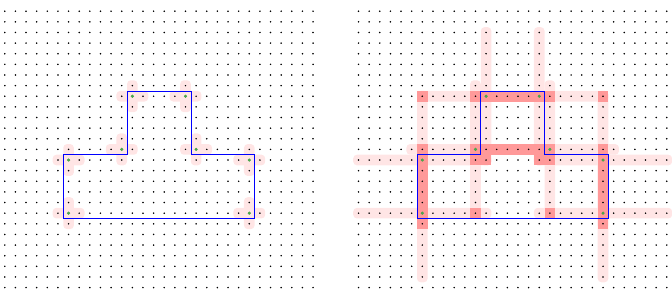
Figure 14 . Illustration of mixing of corner contributions in Lifshitz theories. The left belongs to z = 1 case which there is no mixing and the logarithmic term in the EE is additive. The right panel belongs to z = 6 which there are several points which are correlated to more than one green point, thus the corner contributions are no more